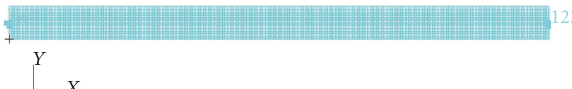
Figure 2: 3D mesh model of the simply supported cracked